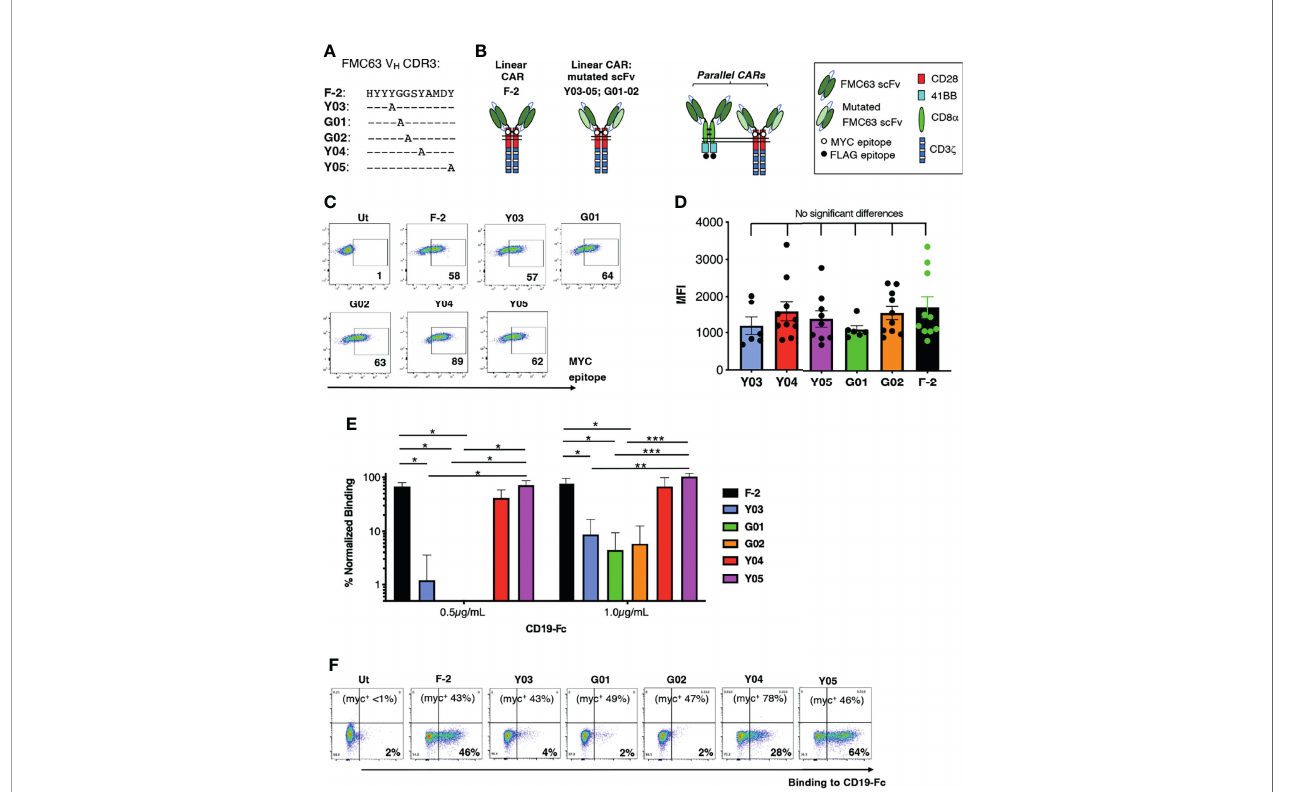
FIGURE 1 | Engineering of a panel of CD19-speci fi c CARs. (A) The indicated mutations were introduced into the V H CDR3 region of an FMC63 scFv. (B) Unmodi fi ed and mutated FMC63 scFvs were used to target 2G (CD28+CD3 z ) CARs. The CAR containing the unmodi fi ed scFv was dubbed F-2 while CARs containing a modi fi ed scFv are named according to the amino acid within V H CDR3 that has been substituted with alanine. Structure of CD19 pCARs is also shown. Each consists of a CD28+CD3 z 2G CAR targeted by a mutated FMC63 scFv and co-expressed with a 4-1BB CCR in which an unmodi fi ed FMC63 scFv confers CD19 speci fi city. (C) Primary human T-cells were transduced with the indicated CD19-speci fi c CARs and were analyzed by fl ow cytometry 5 days after gene transfer. Cells were incubated with 9e10 antibody, which detects an embedded MYC epitope tag within the CAR, followed by goat anti-mouse secondary antibody. Data are representative of 7 independent replicate experiments. (D) Mean fl uorescence intensity of CAR expression (mean ± SEM, n=6-10). Statistical analysis was performed using one-way ANOVA. (E) CAR T-cells were incubated with CD19-Fc protein (0.5 or 1.0µg/mL). Binding of Fc fusion protein was detected with Alexa-Fluor ® 647 V H conjugated anti-human IgG. The indicated proportion of CAR- expressing T-cells in each culture was determined by fl ow cytometry as described in C (mean +/- SEM, n=3 independent donor replicates). Following subtraction for non- speci fi c binding to untransduced cells, data were normalized for the % CAR-expressing T-cells present. Statistical analysis was performed using one-way ANOVA. *** p < 0.001; ** p < 0.01; * p < 0.05. One representative example of this analysis is also presented (F) . Cell surface CAR expression was detected using anti-MYC antibody (percentage indicated in the top of each panel). Binding to a CD19-Fc fusion protein is shown for each CAR T-cell